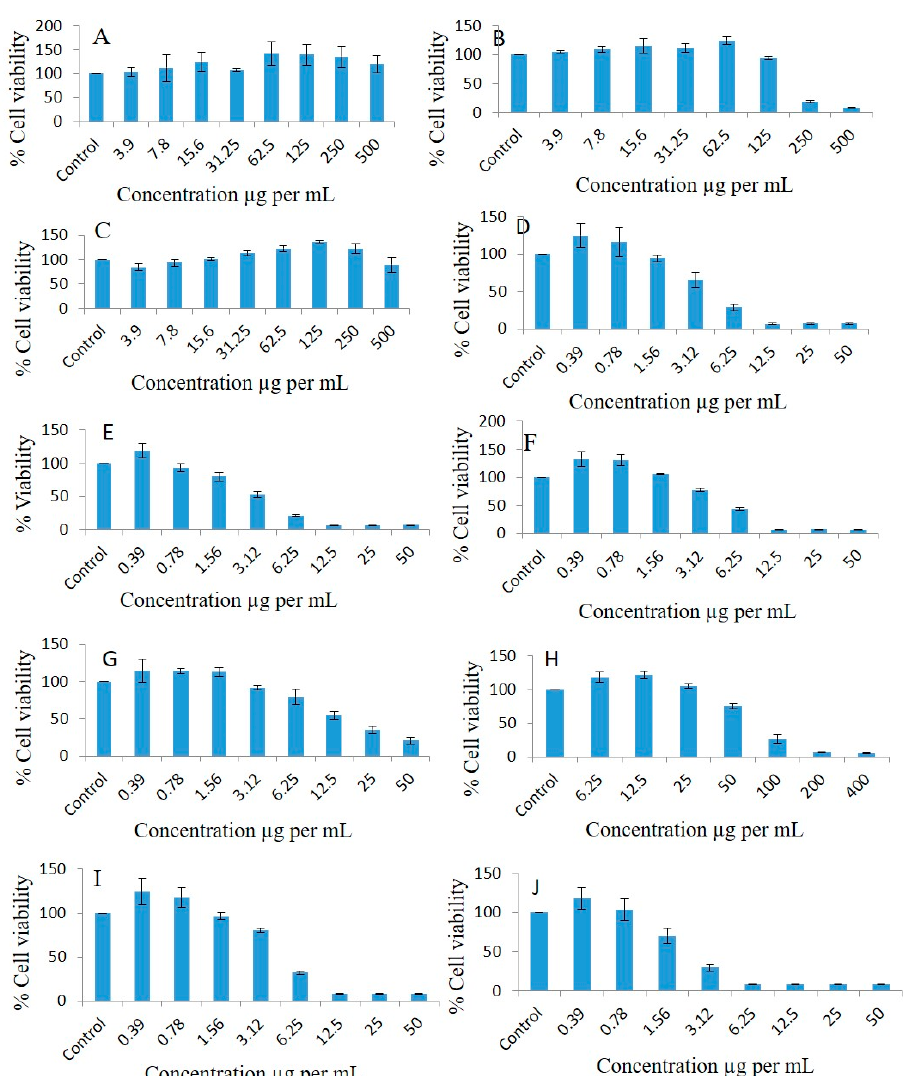
Figure 8. Effects of different concentrations of FSO ( A ), BSO ( B ), ZRO ( C ), F4-systemsloaded RMV ( D ), F4-systems-loaded BRB ( E ), F4-blank (drug free systems) ( F ), pure BRB ( G ), pure RMV ( H ), F4-systems-loaded RMV and BRB ( I ), F5-bio-SNEDDS-loaded RMV and BRB ( J ) on the cell viability percentages of the A549 lung cancer cell line as measured using MTT 72 h following exposure.